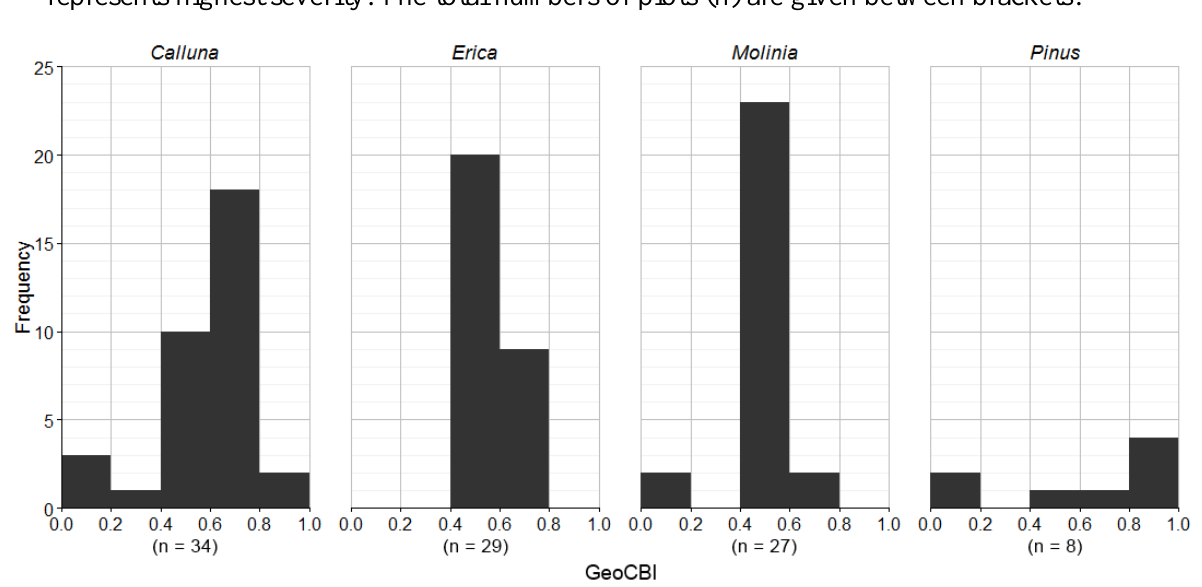
Figure 2. Histograms of Geometrically structured Composite Burn Index (GeoCBI) scores per vegetation type with bin-width 0.2. Unburned plots have a GeoCBI score of 0, while 1 represents highest severity. The total numbers of plots (n) are given between